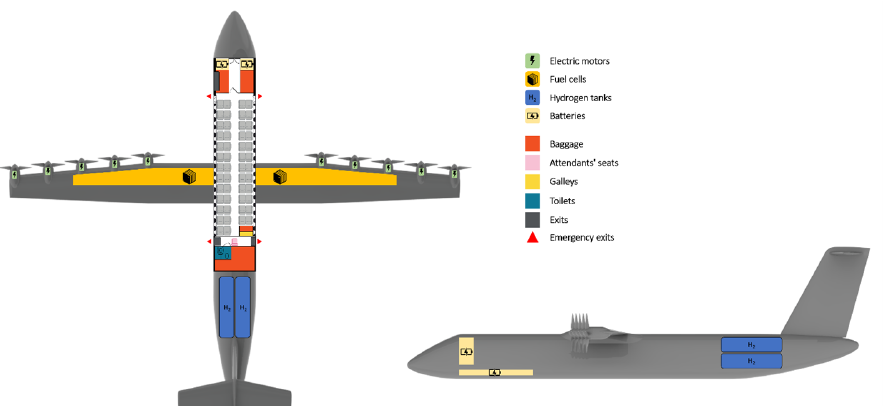
Figure 7. Schematic representation of the FC-based hybrid-electric configuration